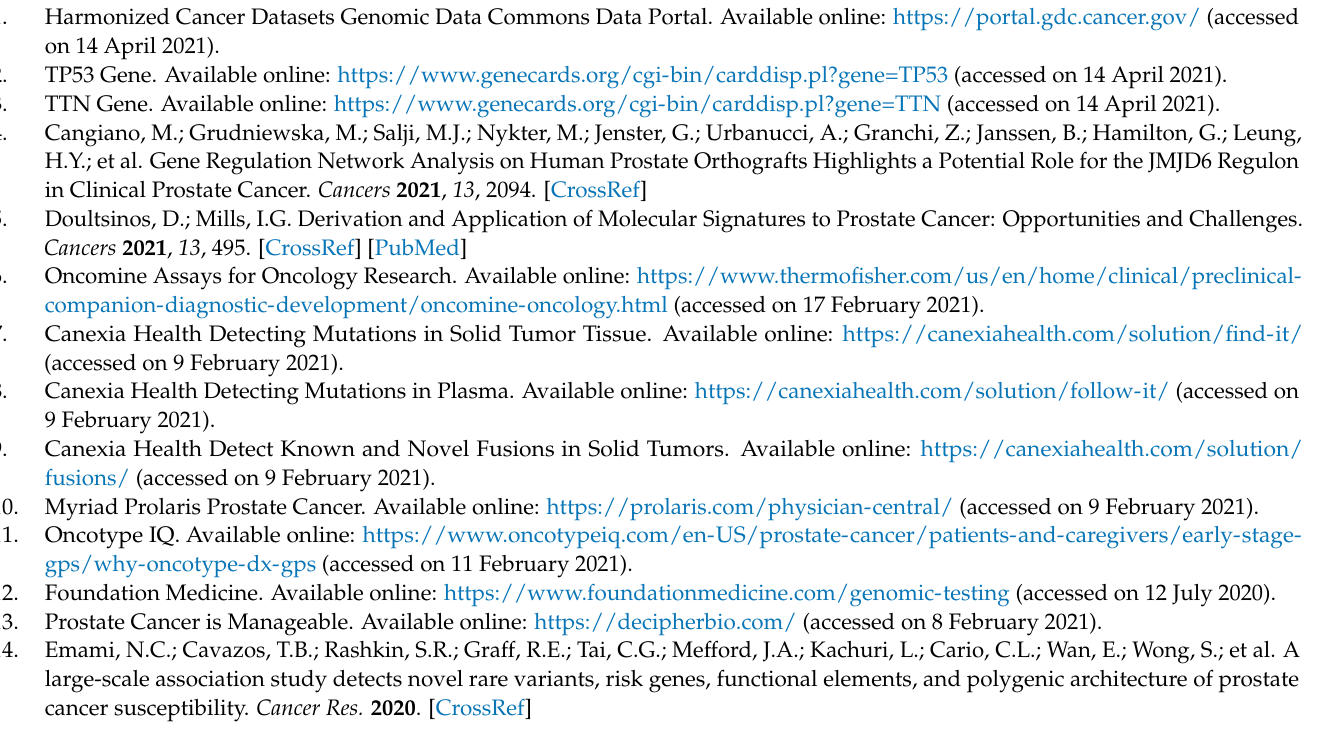
Figure S2. Statistically ( p < 0.05) significantly in-phase (synchronously) and in-antiphase expressed KEGG-determined prostate cancer genes in pairs of profiled